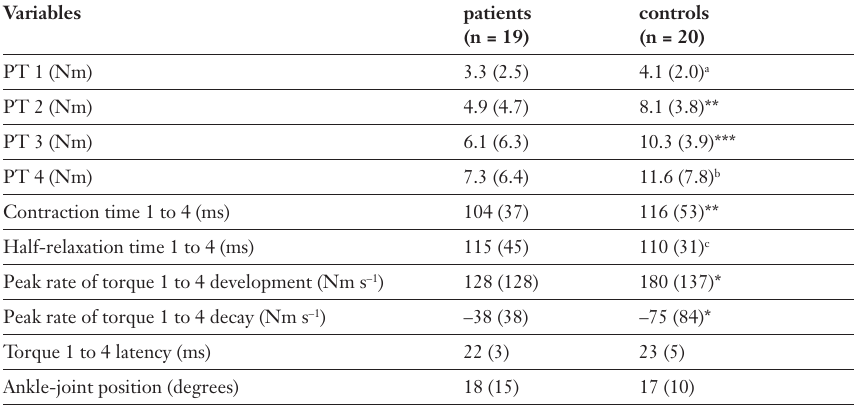
Evaluation of isomet- ric muscle force vari- ables of the ankle dorsiflexors; critically ill patients after one week of ventilation and immobilisation vs controls.